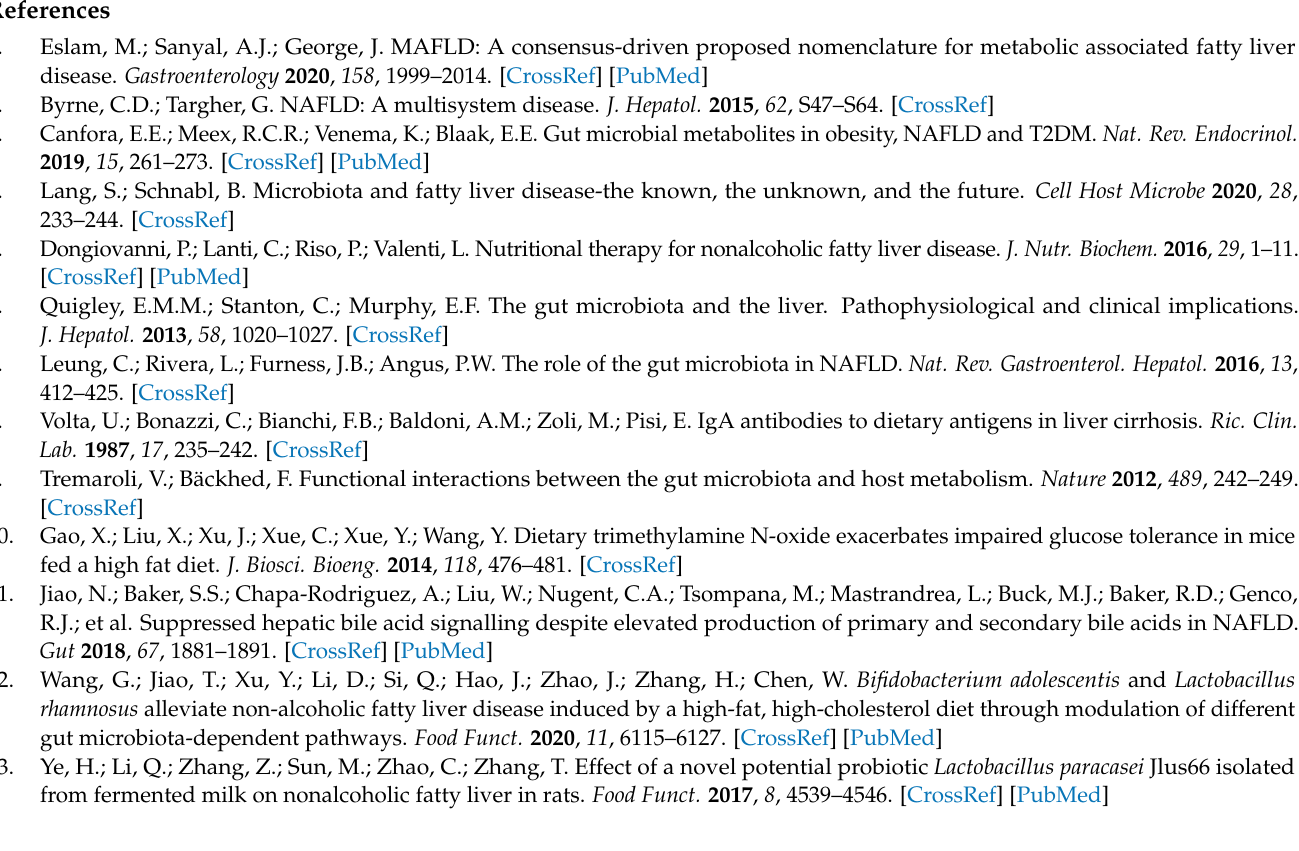
phenotype measurements, Figure S2: Relative expression of TNF- α (A) and IL-6 (B) mRNA in adipose tissue, Figure S3: F. prausnitzii treatment prevented hepatic fibrosis in NAFLD mice, Figure S4: Quantification of F. prausnitzii in feces using RT-qPCR, Table S1: The information of F. prausnitzii strains used in the present study, Table S2: Sequence of primers used in gene expression studies. Supplementary References